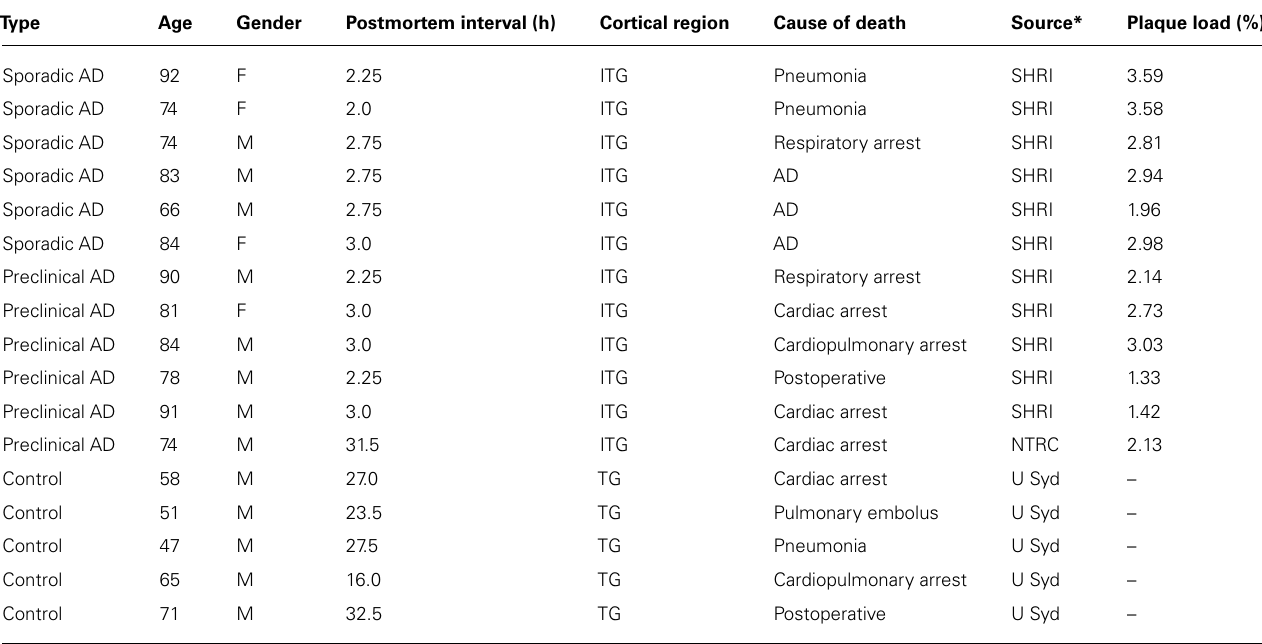
Table 1 | Human brain cases utilized for immunohistochemistry and